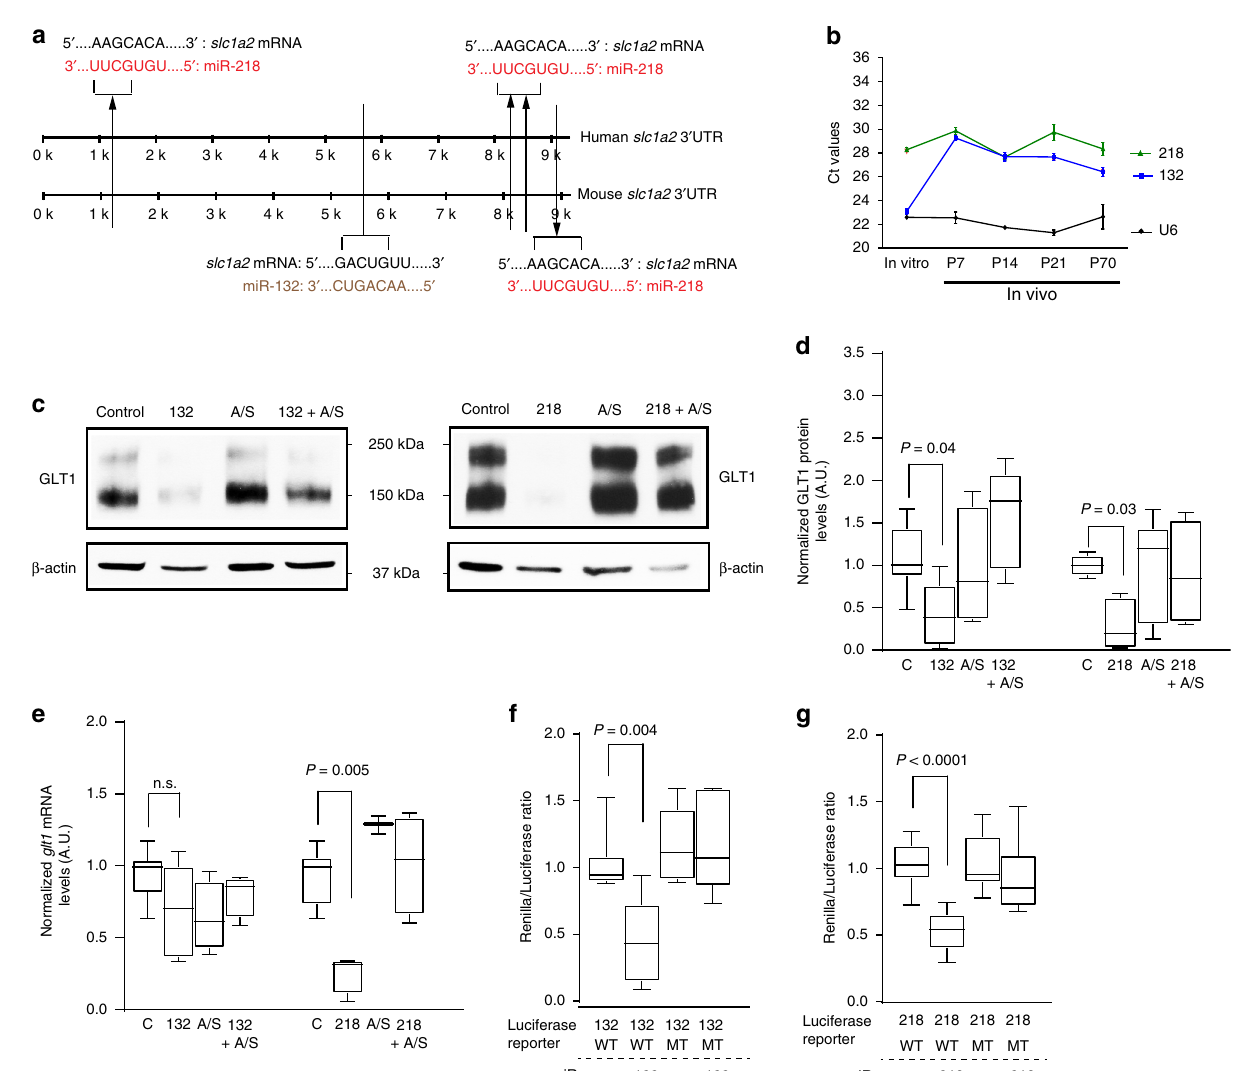
Fig. 8 Identi fi cation of miRs that inhibit GLT1 protein expression in astrocytes. a Schematic diagram of the human and mouse slc1a2 3 ′ UTR with predicted binding sites for miR-218 and miR-132. TargetScanMouse was used for the slc1a2 sequence analysis. Each arrow points to one binding site. b Expression levels of miR-218 and miR-132 in astrocytes in vitro (cultured astrocytes alone) and in vivo (at P7, P14, P21, and P70). Representative GLT1 immunoblots ( c ), quanti fi cation of GLT1 protein levels ( d ), and quanti fi cation by qPCR of glt1 mRNA levels ( e ) from cultured primary astrocytes following transfection of miR-132 or miR-218 mimics, miR-132 or miR-218 antisense (A/S), and miR-132 or miR-218 along with their respective antisense. n = 6 – 8 independent experiments per condition. P- values were determined using one-way ANOVA and post hoc Tukey ’ s test. n.s .: not signi fi cant; f Wild-type (WT) and miR-132 mutant (MT) GLT1 3 ′ UTR luciferase activity in HEK 293 cells following miR-132 transfection. g Wild type (WT) and miR-218 mutant (MT) GLT1 3 ′ UTR luciferase activity in HEK 293 cells following miR-218 transfection. n = 3 independent experiments with six replicates per experiment per condition; one- way ANOVA and post hoc Tukey ’ s test; The data was presented in the box and whisker plot with de fi ned elements, median (center line), upper and